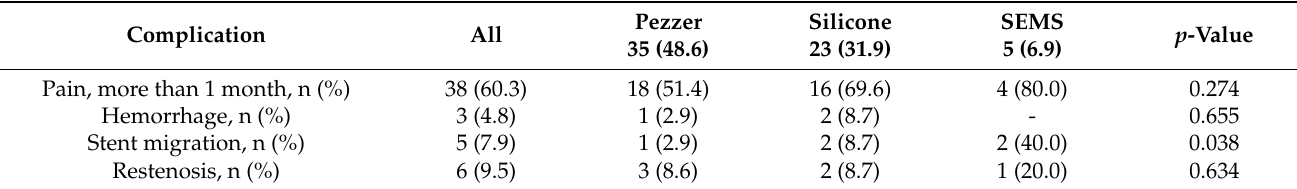
Table 2. Post-stent placement